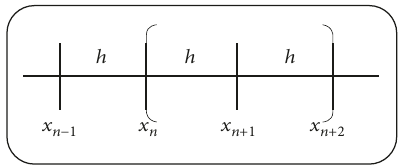
Figure 1: Two-point multistep block